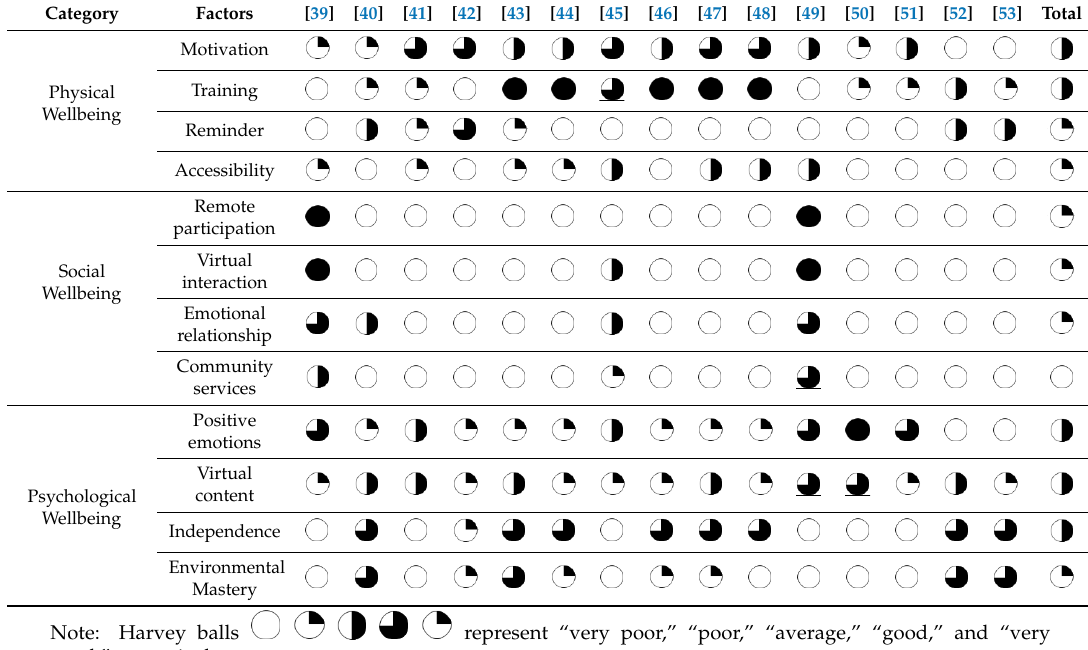
Table 3. Critical analysis of selected AR and VR applications.